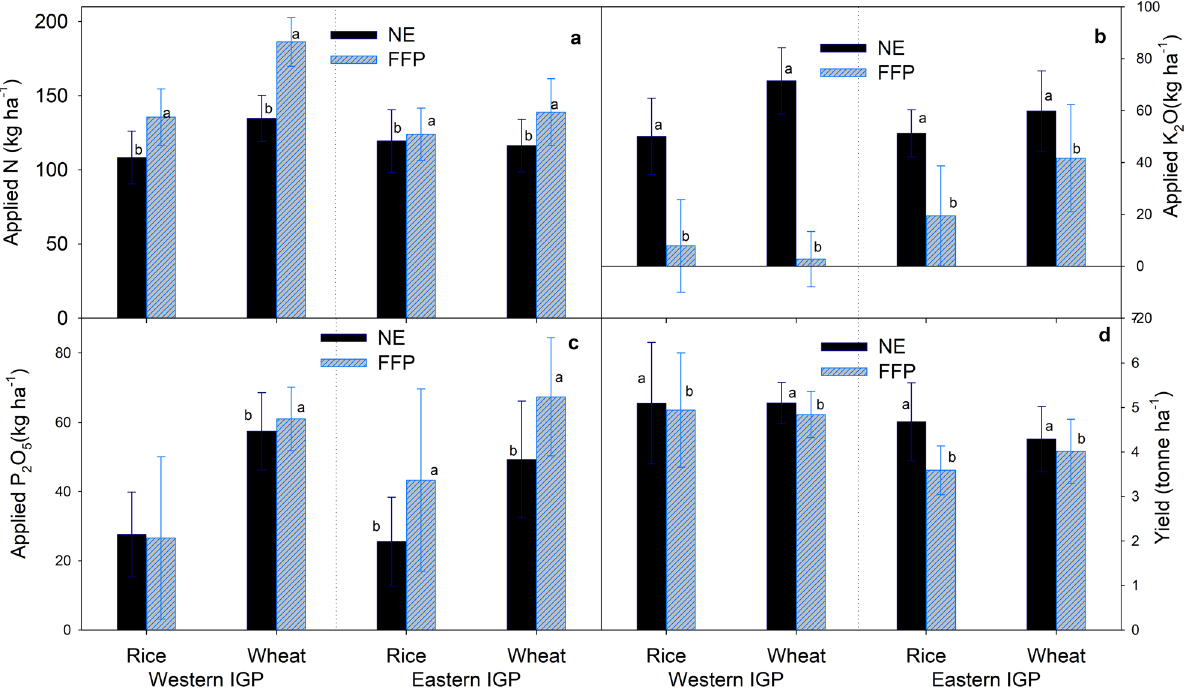
Figure 1. Rate of nitrogen ( a ), potash ( b ) and phosphorus ( c ) application and grain yield ( d ) from rice and wheat under Nutrient Expert (NE) and Farmers’ Fertilizer Practices (FFP) in the study areas. Values are average of all the comparison trials over the study period. Within each pair, bars bearing different lowercase letters are significantly different from each other based on the paired t-test (p = 0.05). The error bar shows the standard deviation. IGP = Indo-Gangetic